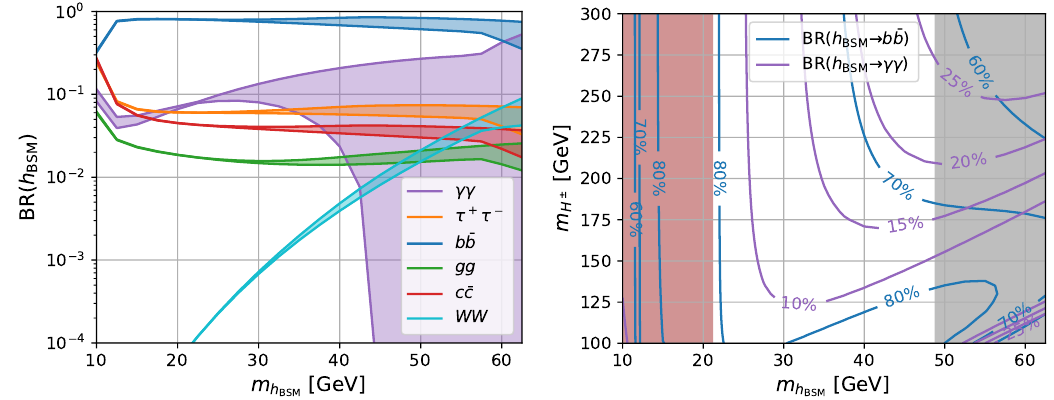
) benchmark scenario. The left panel BSM . The decay h additionally depends h BSM BSM → γγ ) parameter plane of , m h H ± BSM